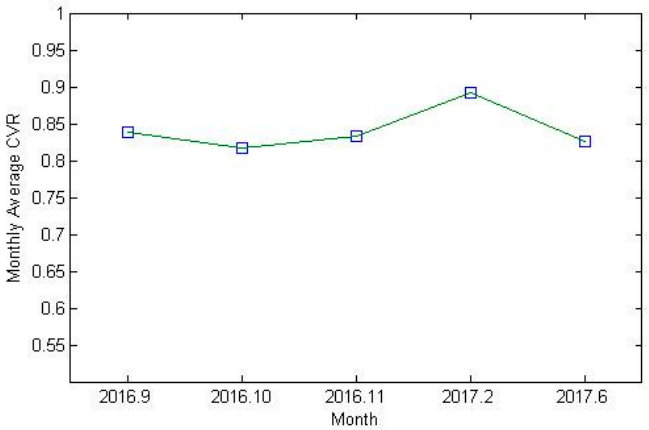
Figure 7. Average CVR factors of all D/Ls classified by season.